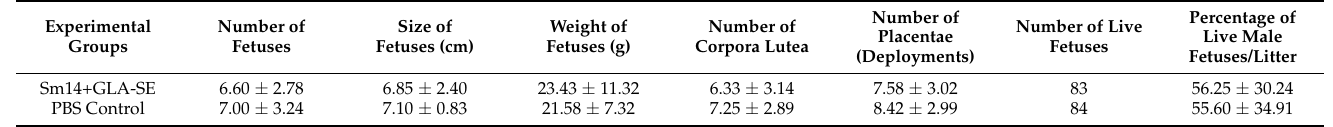
Table 1. Sm14 vaccination does not induce changes in pregnancy parameters.